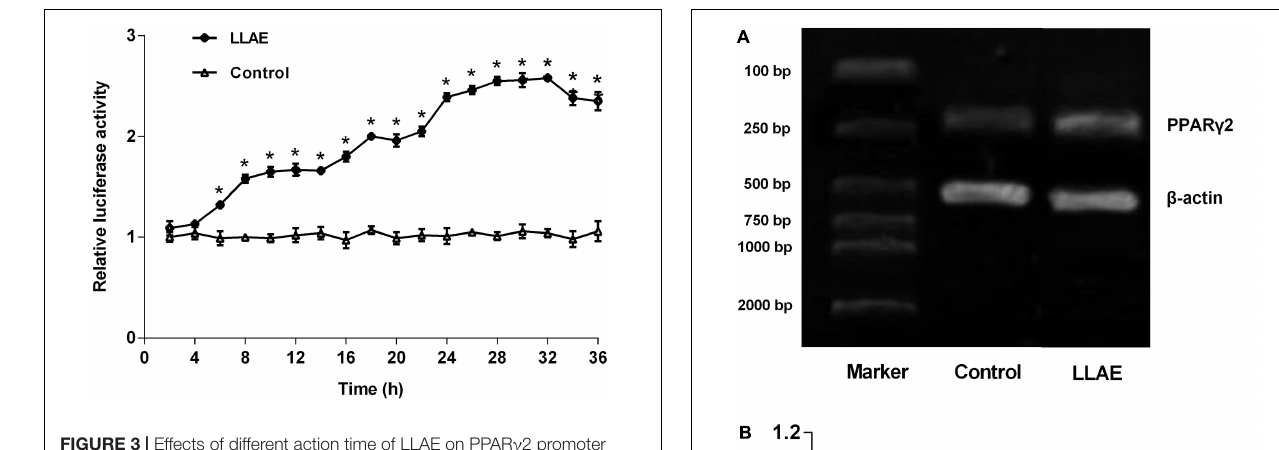
or not it could promote the PPAR γ 2 expression in adipocytes?